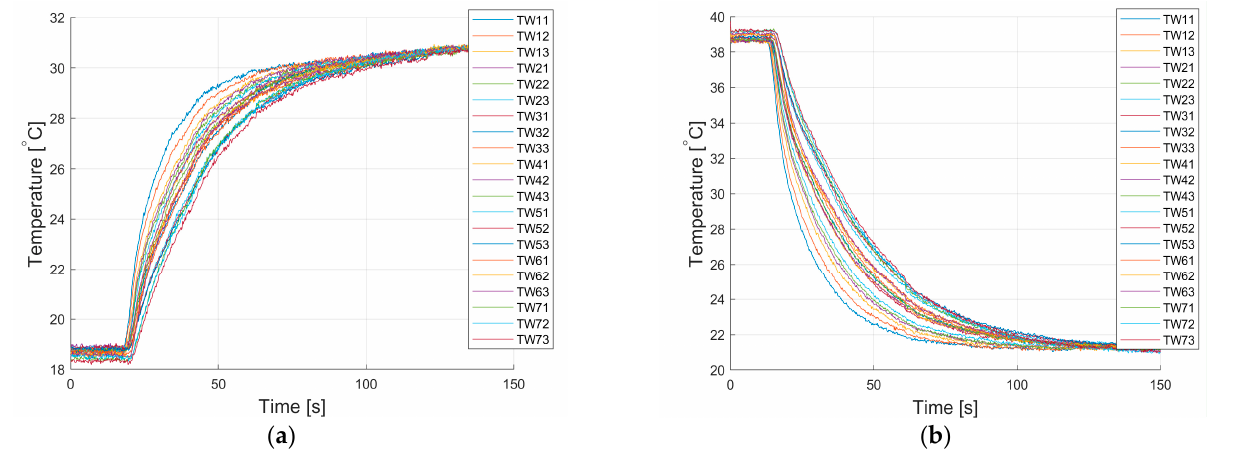
Figure 8. Visualization of measurement results—step responses determined based on measurements with a thermovision camera at the observed measurement points: ( a ) object heating process, ( b ) object cooling